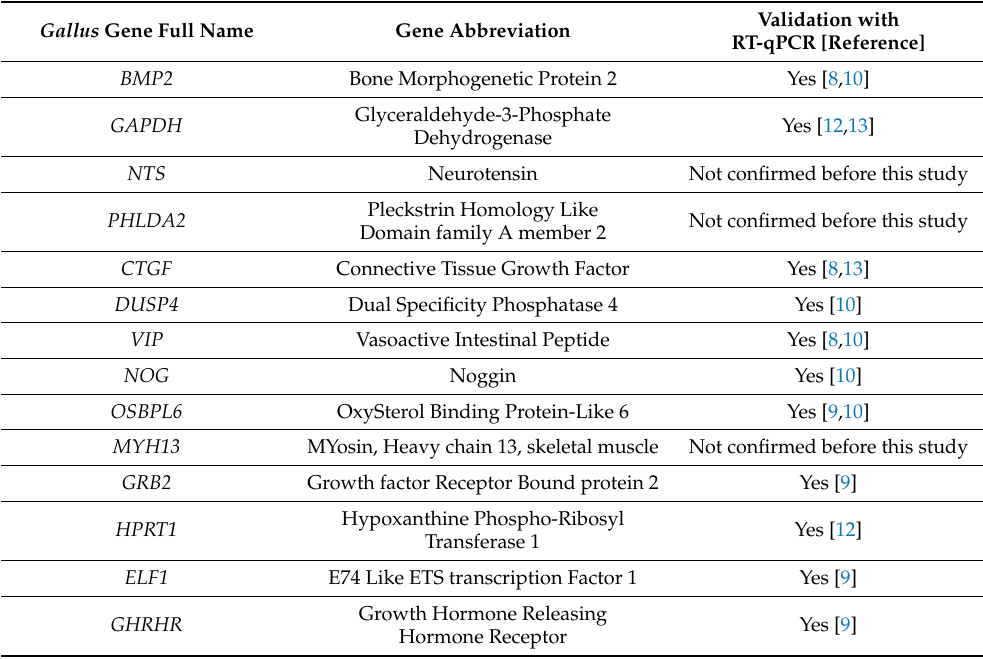
Table 1. List of retinal genes used in the present study (full and abbreviated names) and whether their expression has been validated by RT-qPCR in previous studies (in adult-stage retinas). The previous studies are listed in